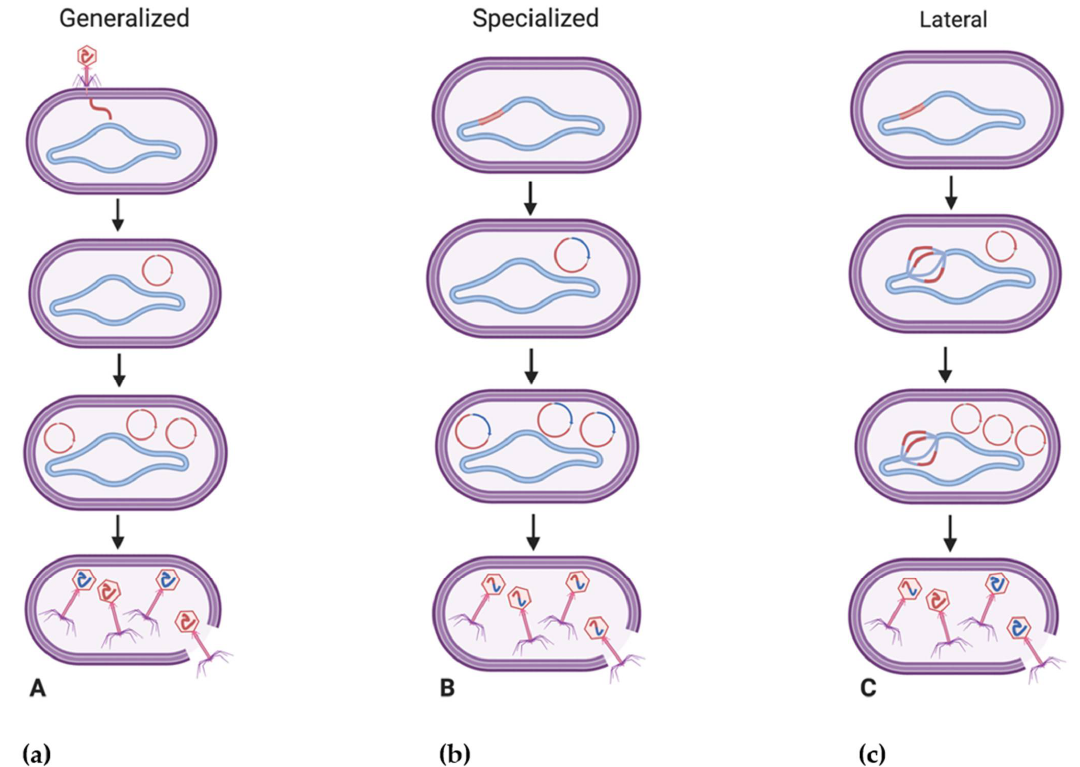
Figure 2. Bacteriophage-mediated transduction. Simplified depiction of generalized ( a ), specialized ( b ), and lateral transduction ( c ). Viral genome is represented in red while the bacterial genome is represented in blue. Note the varying presence of viral and bacterial genetic material differing across the three mechanisms of phage-mediated transduction. Adapted from [98].